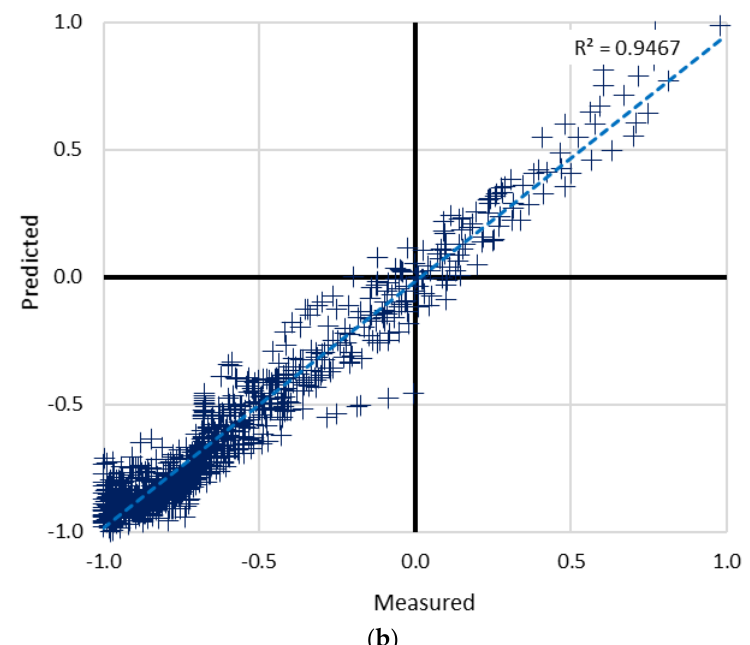
Figure 15. Training and testing outcomes form ICA – ANN model in estimating F ult.; ( a ) ICA-ANN-training dataset, ( b ) ICA-ANN-testing dataset